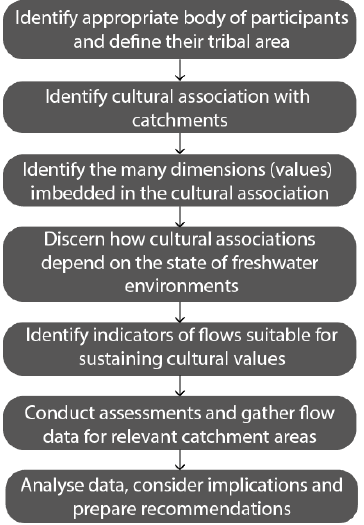
Figure 7. Steps in the SAM. Modified from Tipa